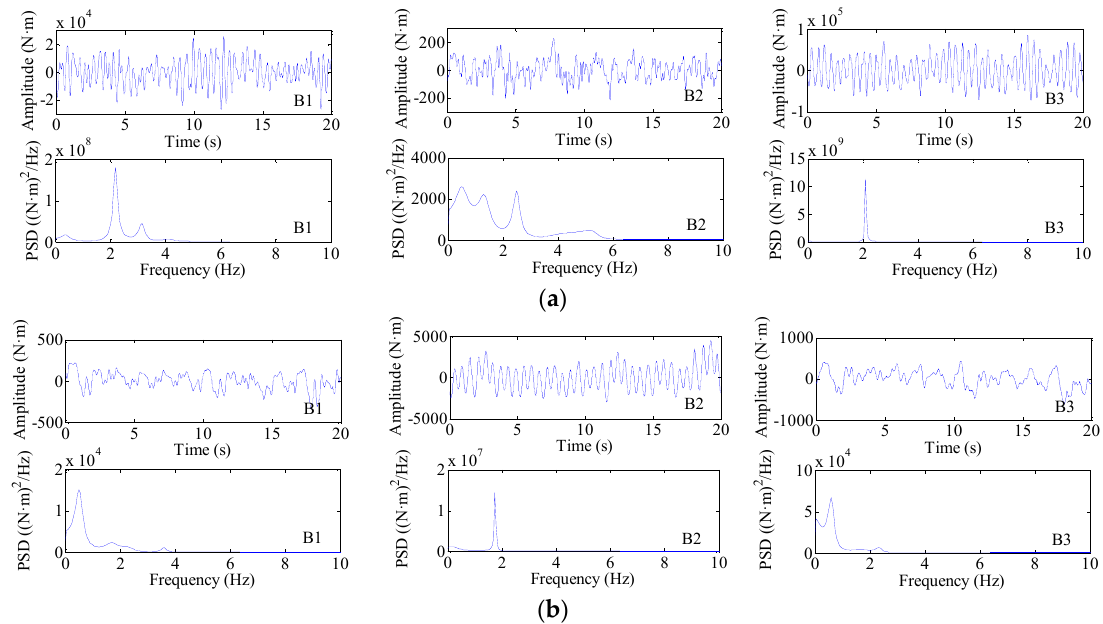
Figure 19. The fluctuation characteristic of M Y B of the three blades of the wind rotor in the θ = 30 ˝ parking position: ( a ) β = 90 ˝ ; ( b ) β = ´ 90 ˝